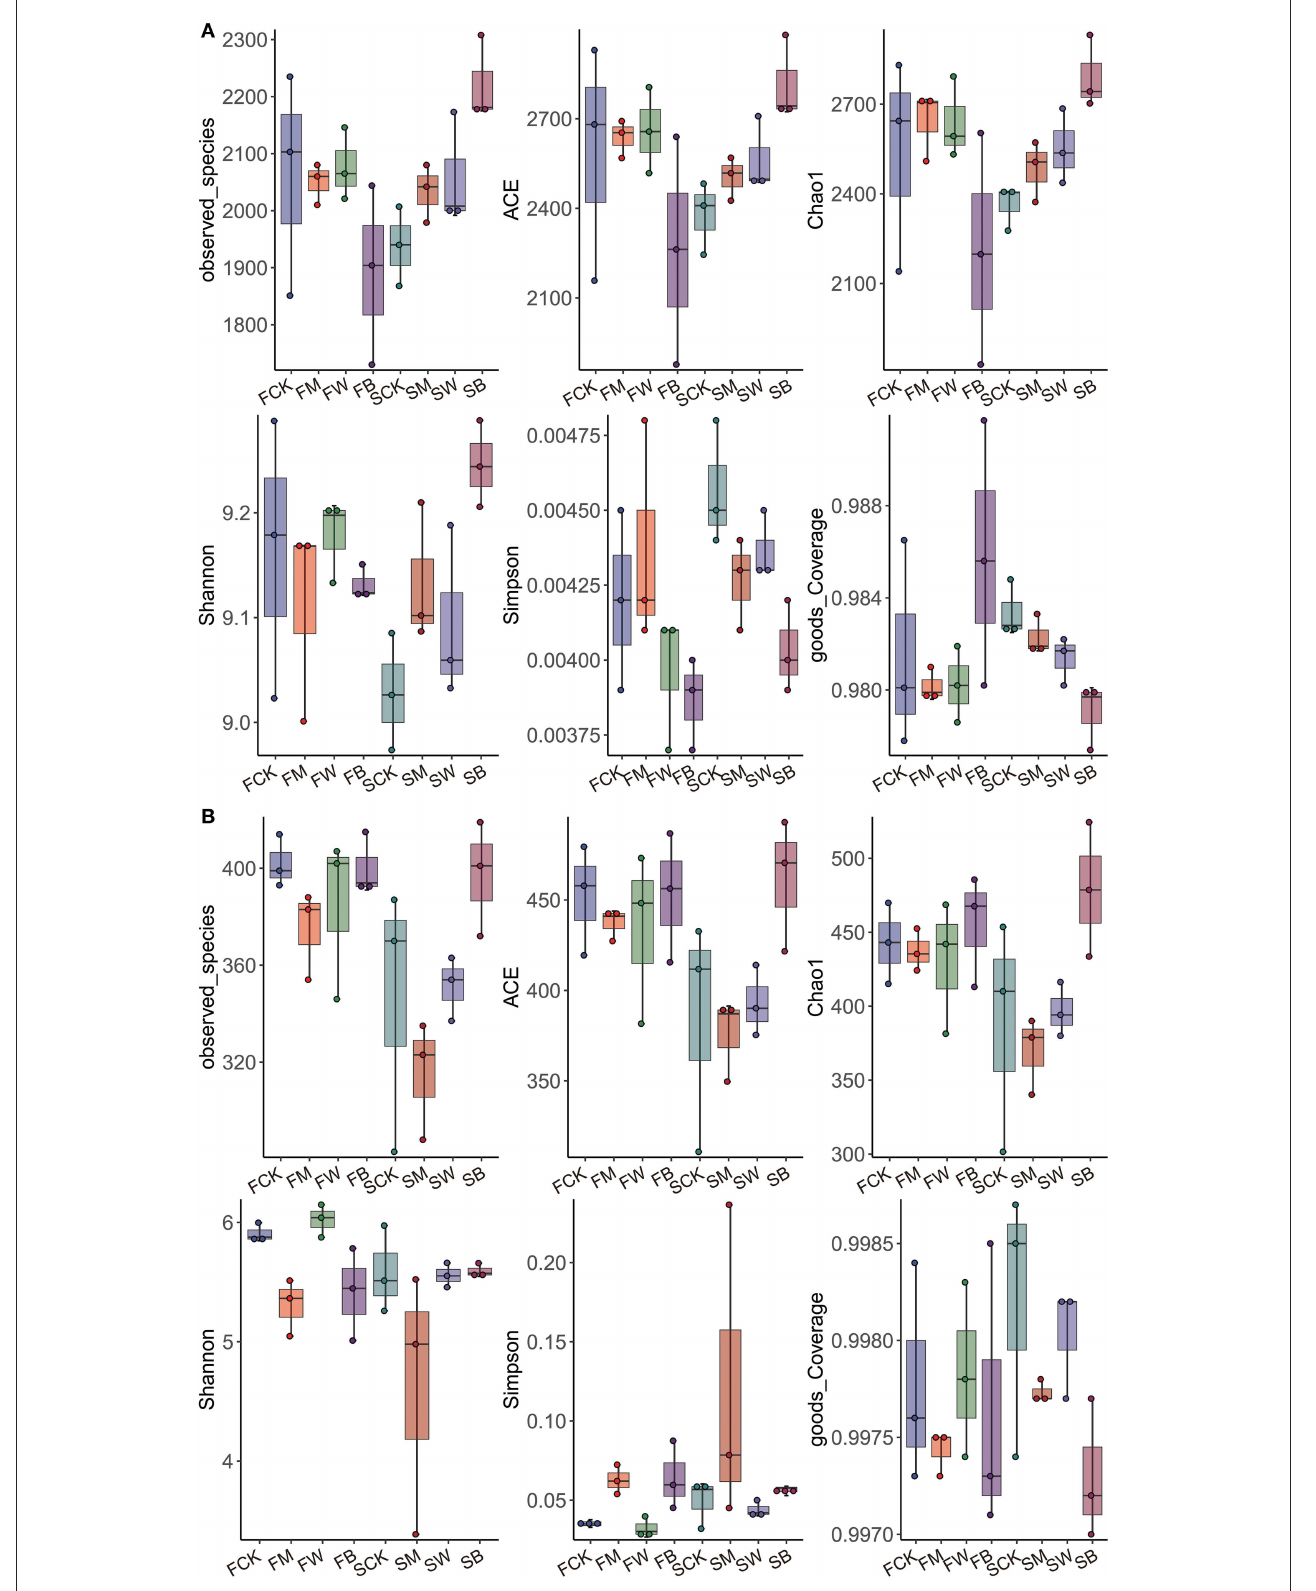
FIGURE1 α -diversity of bacteria and fungi among the eight treatments during the two seasons. α -diversity of bacterial microorganisms in the soil (A) . α -diversity of fungal microorganisms in the soil (B)